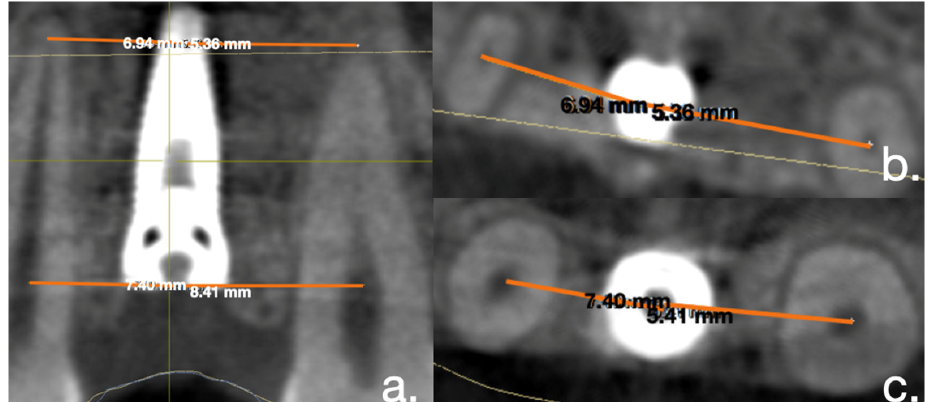
Figure 3. Comparison of mesiodistal deviation with adjacent teeth on CBCT scans performed after implant surgery to verify the congruence of implant placement. ( a ) Implant position after implant surgery in coronal projection; ( b ) mesiodistal deviation of the implant after computer-guided surgical insertion with adjacent teeth at implant axis in axial projection; ( c ) mesiodistal deviation of the implant after computer ‐ guided surgical insertion with adjacent teeth at implant head in axial pro ‐ jection.